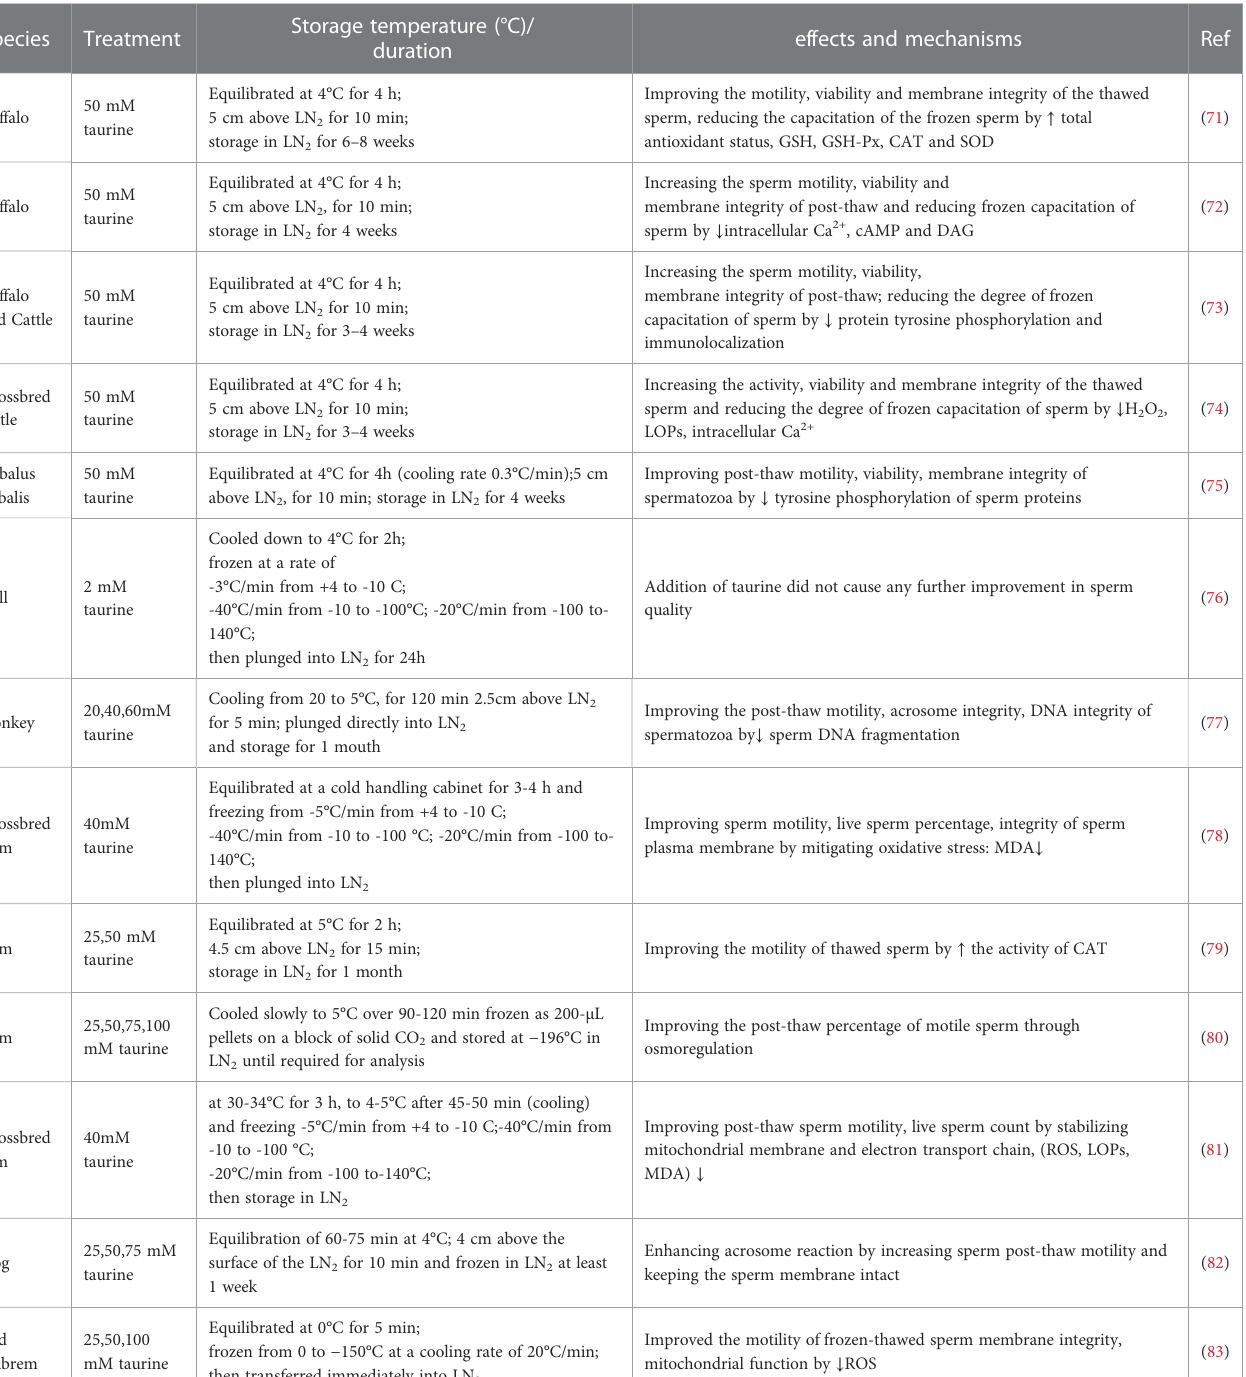
TABLE 1 Protective effect of taurine on cryopreservation of sperm. Species Treatment